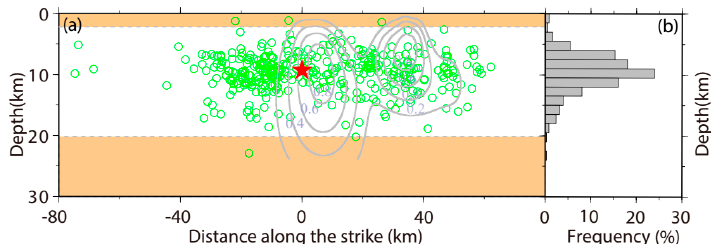
Figure 10. ( a ) Relocated hypocenters of the aftershock sequences [1] following the 2016 Aketao earthquake and projected onto a strike-depth plane. The red star represents the epicenter of the main shock. The gray contours represent the optimal slip distributions inverted in this study. The regions marked by the orange color represent the frictionally stable field [56]. The two dashed gray lines from top to bottom depict a depth of 3 km and 20 km, respectively. ( b ) Histogram of the depth distribution of aftershocks for the 2016 Aketao earthquake.